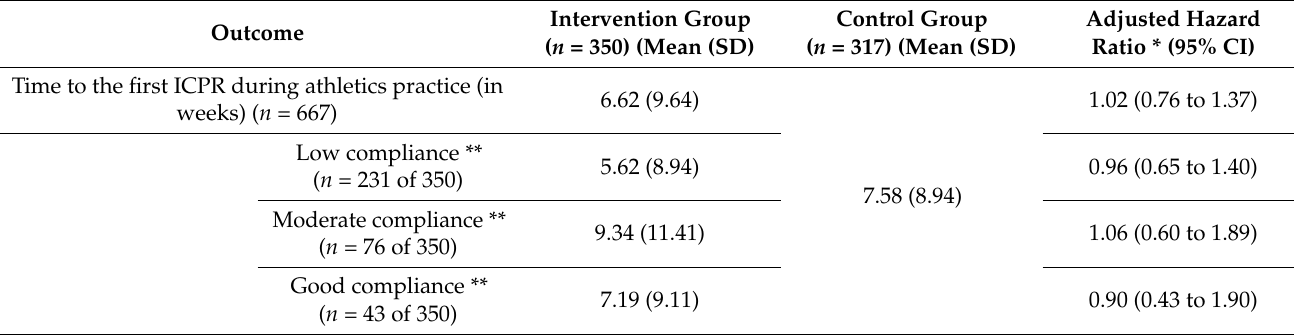
Table 5. Secondary outcome results: survival analysis to evaluate the time before the first participation restriction injury complaint leading to participation restriction (ICPR) (in